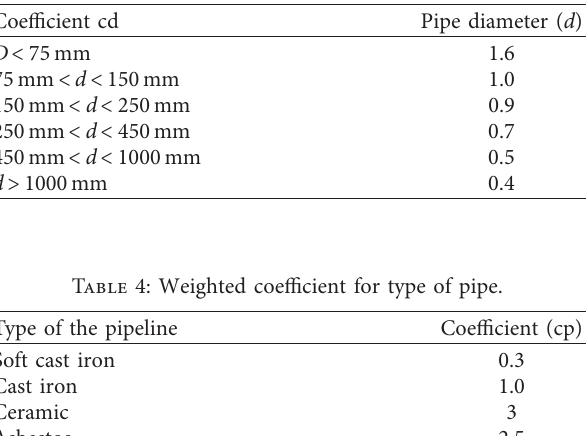
Table 3: Weighted coefficient for diameter of a pipe.